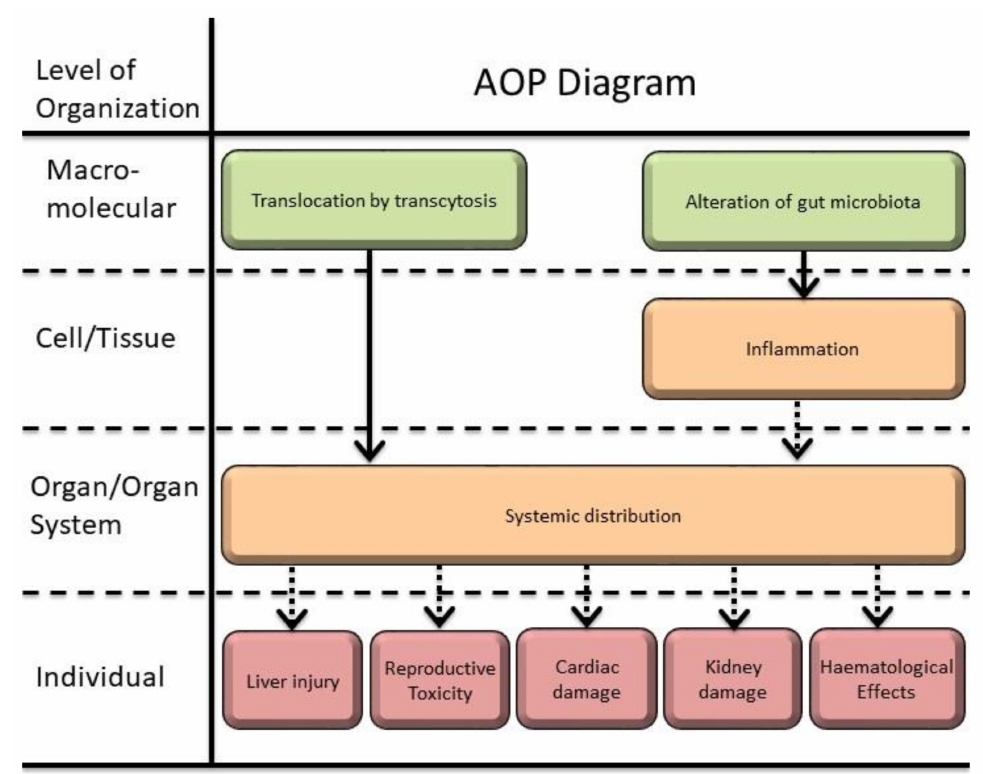
Figure 5. Proposal of a putative AOP model upon TiO 2 -NPs ingestion effects after systemic